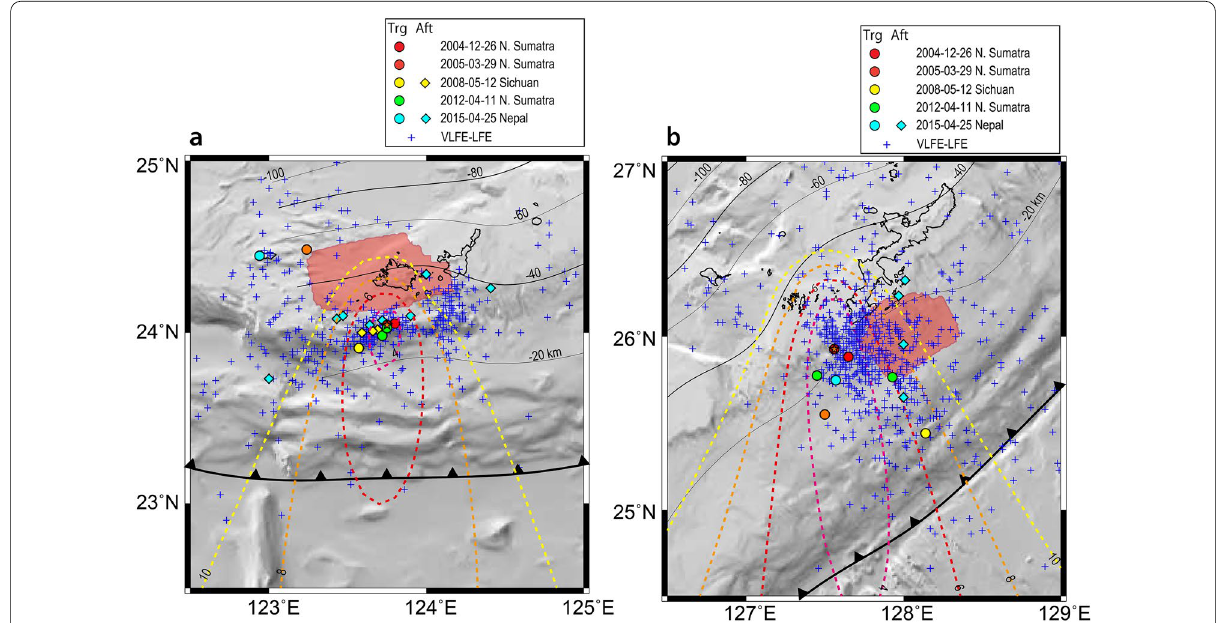
Fig. 4 Epicentral distribution of the LFEs. a Epicentral distribution of the LFEs in the Yaeyama area. Circles show the epicenter of the triggered LFEs during the passage of the surface waves. Diamonds denote the epicenters of LFEs after the passage of the surface waves. Colors of the circles and diamonds are different for each teleseismic event. The crosses show the epicenters of VLFE–LFEs (Nakamura 2017). The red hatch shows the slow slip event (SSE) area where the number of SSEs was over 5 (Nishimura 2014). The dotted contours show the RMS errors of the LFEs (denoted by stars) accompanying the surface wave of the 2004 Sumatra earthquake. The black-colored contour shows the depth of the plate interface (Hayer et al. 2012). b The same as a but for the Okinawa